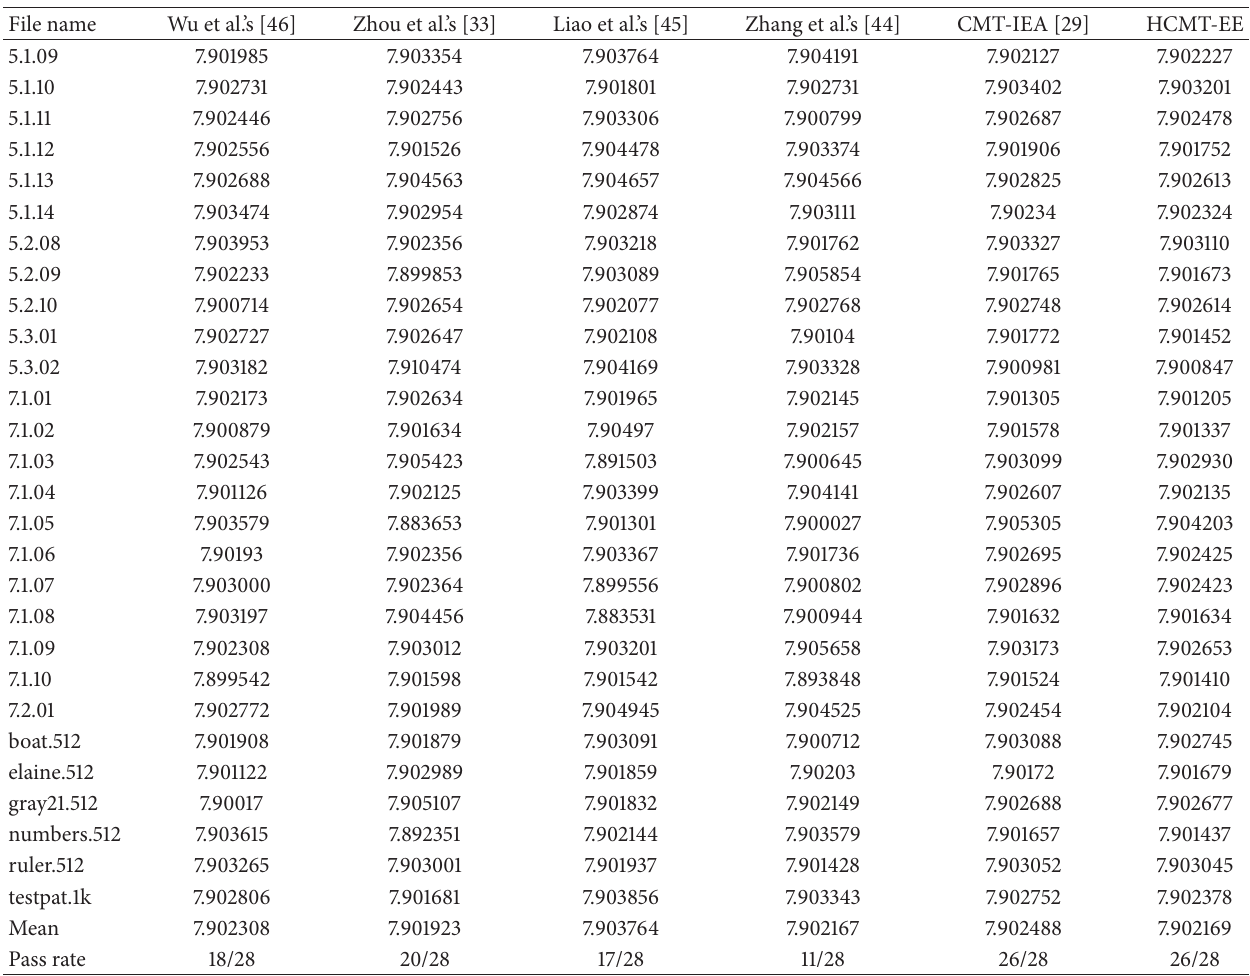
Table 3: This table shows pixel correlation of the line image with CMT, 3D chaotic map algorithm, and